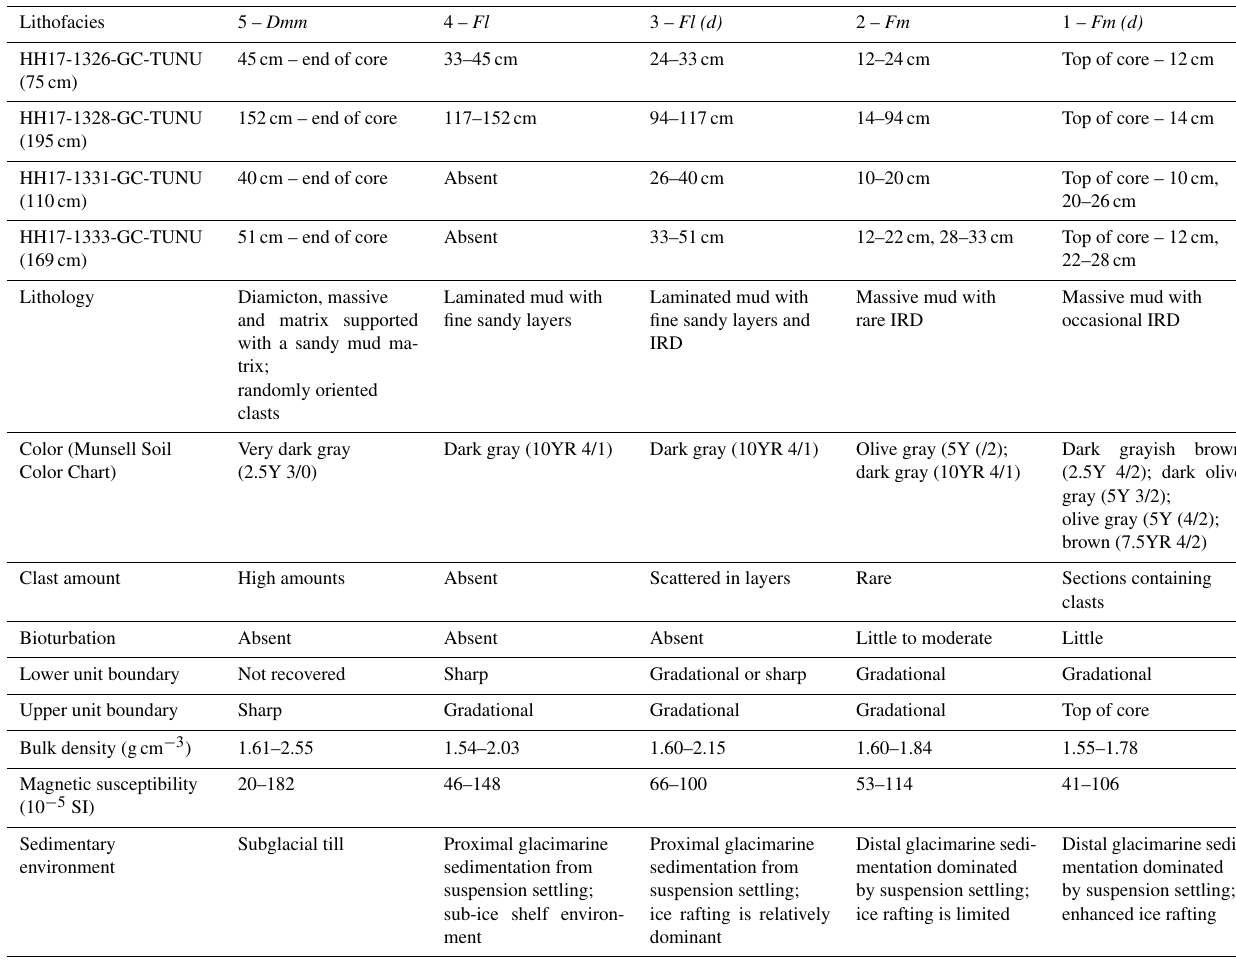
Table 2. Overview of the main properties and compositional characteristics of the lithofacies, as well as depositional environments.